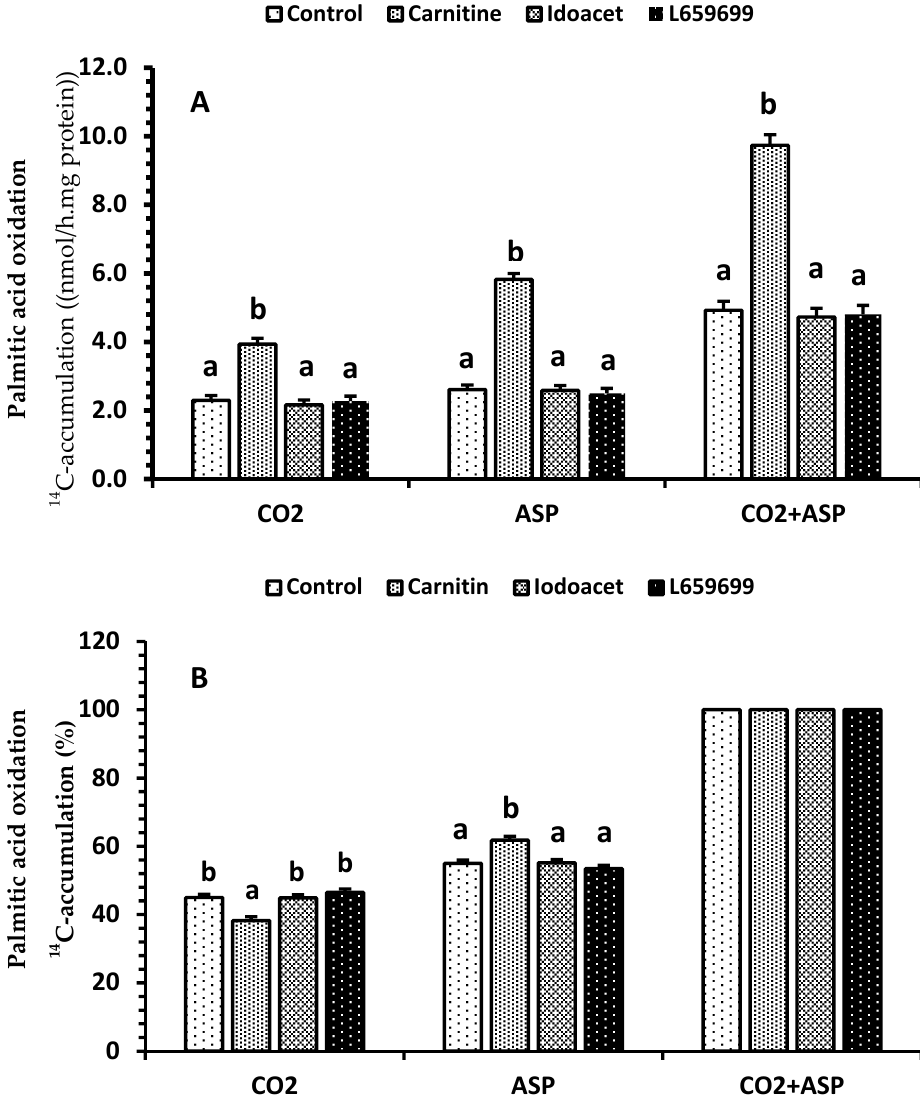
Figure 3. The main effect of carnitine and inhibitors of 3-hydroxy-3-methyl-glutaryl-CoA synthase (HMGCS) and acetoacetyl-CoA deacylase (AACD) on palmitic acid oxidation. Fresh kidney homogenates were incubated with palmitic acid only (control), and carnitine, iodoacetamide (Idoacet), or L659699. Data in A (Lsmeans ± SEM) are 14 C-accumulations in CO 2 , acid soluble products (ASP), and CO 2 + ASP ( n = 16). Data in B (Lsmeans± SEM) are the percentage of the 14 C-accumulations in CO 2 , acid soluble products (ASP), and CO 2 + ASP ( n = 16). a,b Treatments in A and B for CO 2 , ASP, and CO 2 + ASP with different superscripts differ ( p < 0.05).